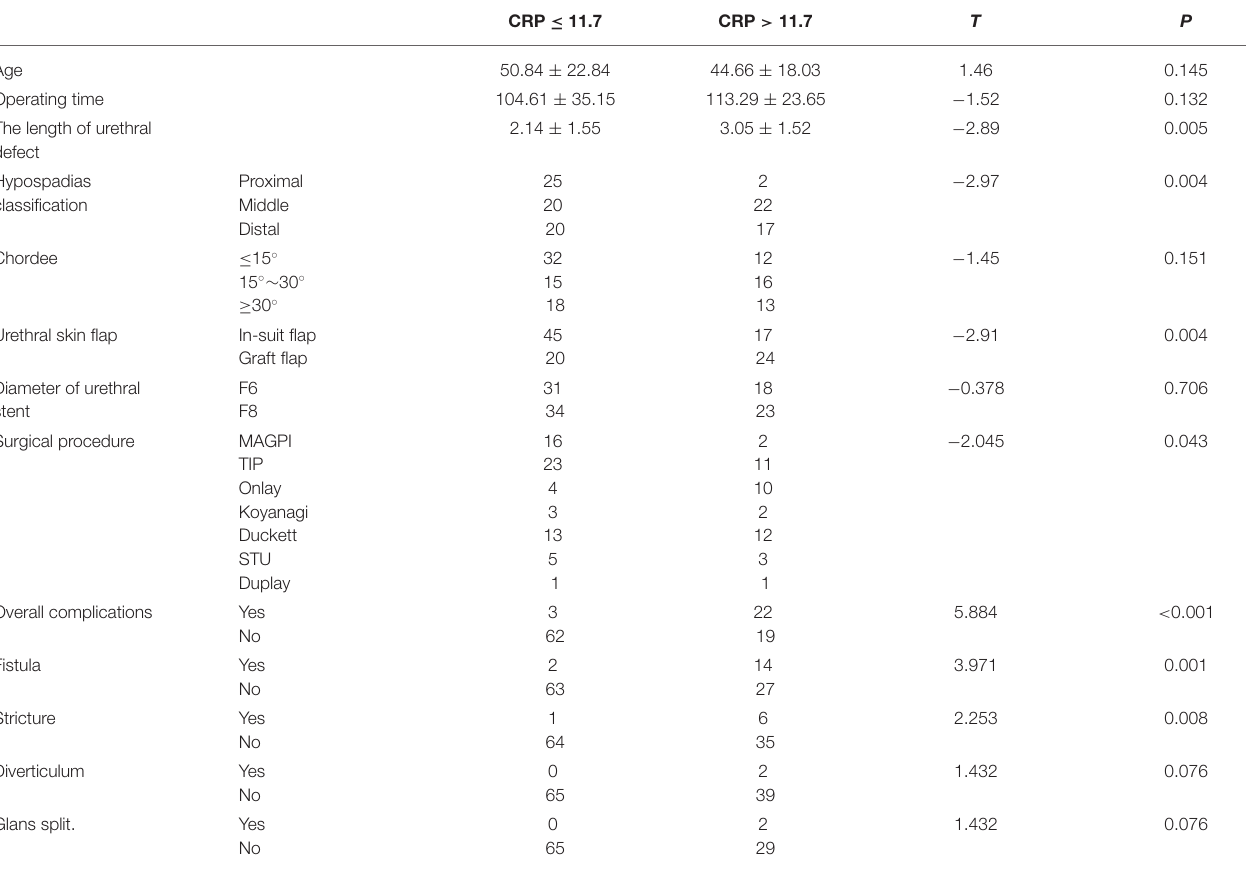
TABLE 3 | Relationship between CRP and clinical characteristics in